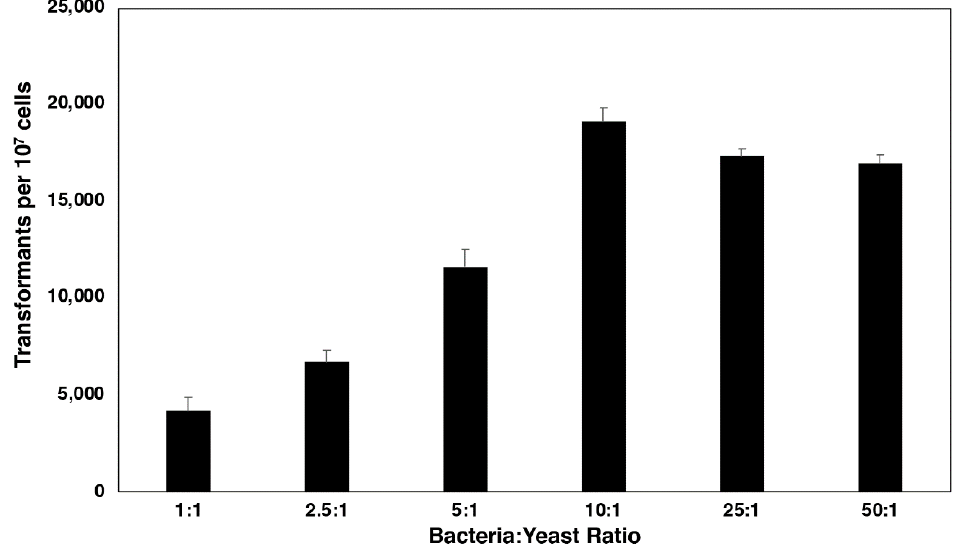
Figure 1. The effect of bacteria:yeast ratios on transformation frequency. C. neoformans and A. tumefaciens cells were mixed in various ratios using the standard protocol, with C. neoformans cells kept constant at 1 × 10 7 . Experiments were performed in triplicate with three plates per experiment and counted at 48 h. Colony counts are per 1 × 10 7 C. neoformans cells. Transformant numbers were significantly different from each other for each ratio, except 25:1 and 50:1, which were not significantly different from each other ( P < 0.05).